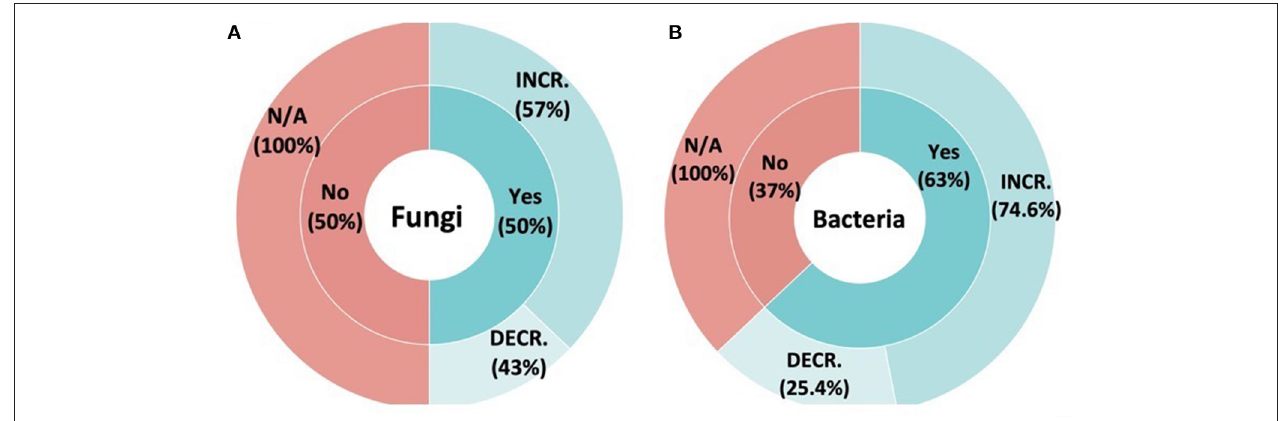
FIGURE 2 | The effect of inoculation on the native (A) fungal and (B) bacterial communities. The inner rings demonstrate whether inoculation affects the native microbial communities’ diversity. The outer rings demonstrate the directional change on SMC diversity (increase vs. decrease) in those samples that were affected by